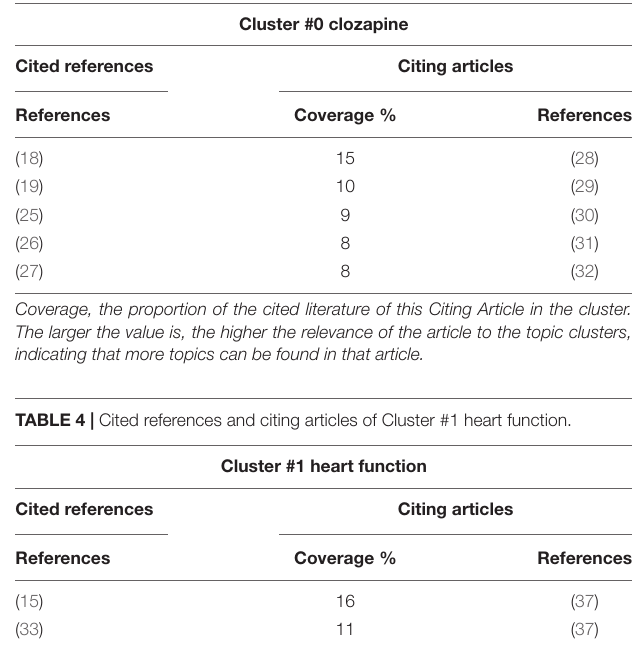
TABLE 3 | Cited references and citing articles of Cluster #0 clozapine.